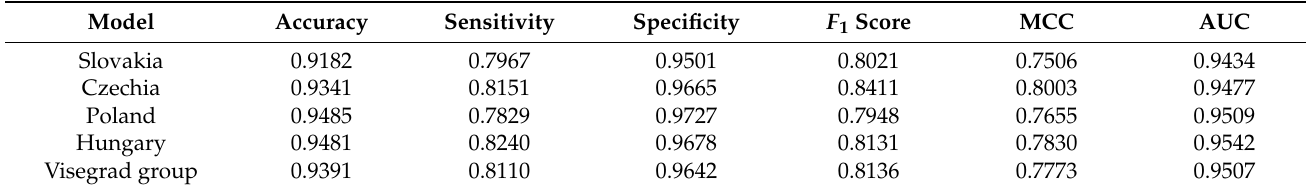
Figure 4. Confusion charts of model prediction on the testing sample. ( a ) Confusion chart of the Visegrad group with normalized row and column values, ( b ) confusion chart of each country separately. Performance metrics derived from the confusion matrix are summarized in Table 7. Table 7. Performance metrics of the proposed model on the testing